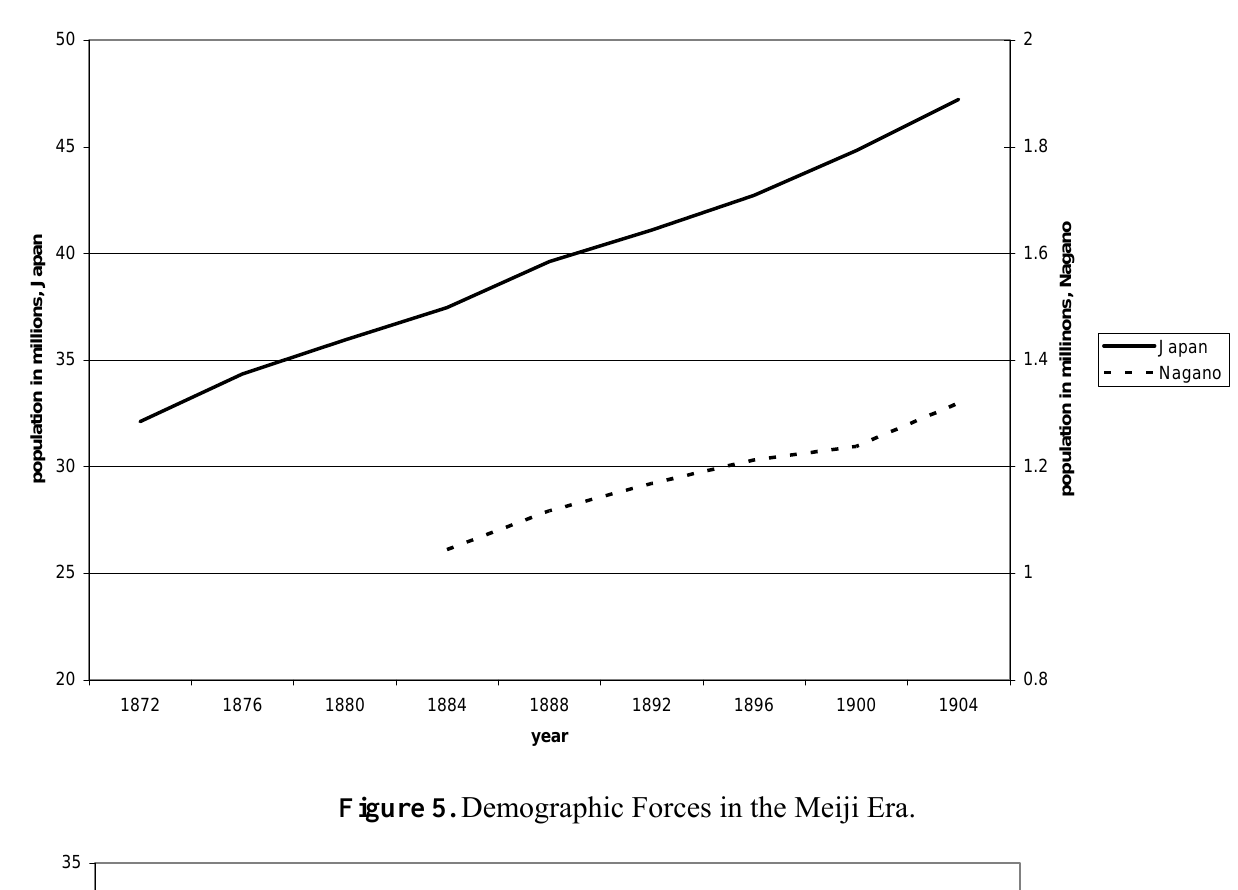
Figure 4. Population Trends during the Meiji Era.